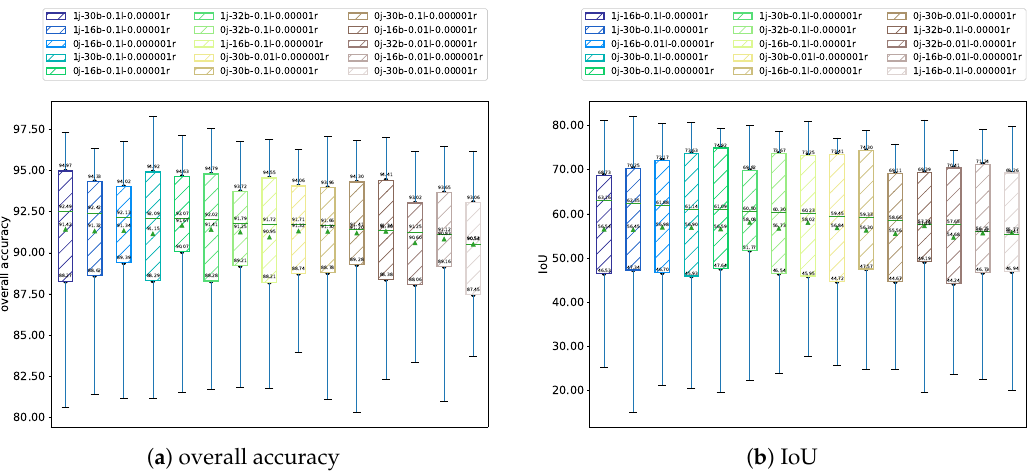
Figure 10. Segmentation satellite results on the ITESM dataset (14 images): ( a ) is by using dlib’s measure–overall accuracy, ( b ) shows IoU. The bests model considering the medians (the mean is vulnerable to outliers) are for ( a ) 1j-30b-0.1l-0.000001r and for ( b ) 0j-16b-0.1l-0.00001r. The experiments were named according to the following naming convention: <jittering was used> j - <batch size> b - <initial learning rate> l - <minimum learning rate> r .